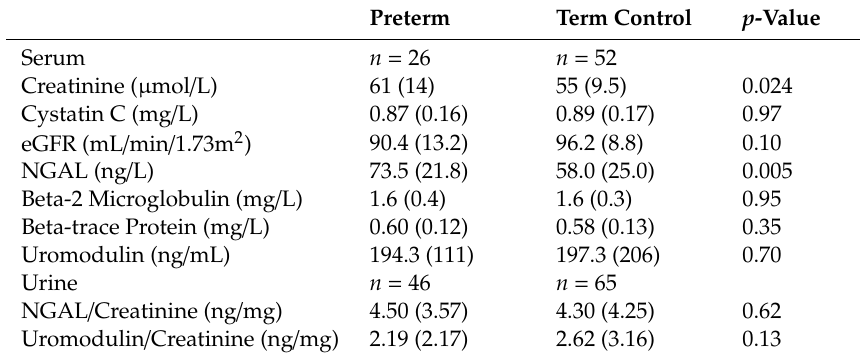
Table 5. Renal biomarkers in serum and urine in preterm-born and term-born control study participants. Preterm Term Control p -Value Serum n = 26 n = 52 Creatinine ( µ mol /